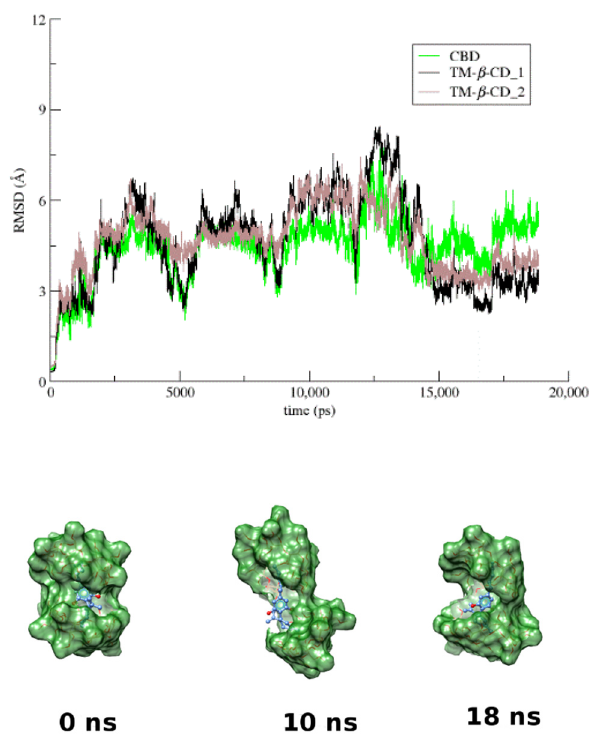
Figure 6. RMSD from the first frame of the trajectory for encapsulated CBD (green) in TM- β -CD dimer (black and brown) as a function of MD simulation time and representative snapshots of CBD/TM- β -CD inclusion complex at 0, 10, and 18 ns.